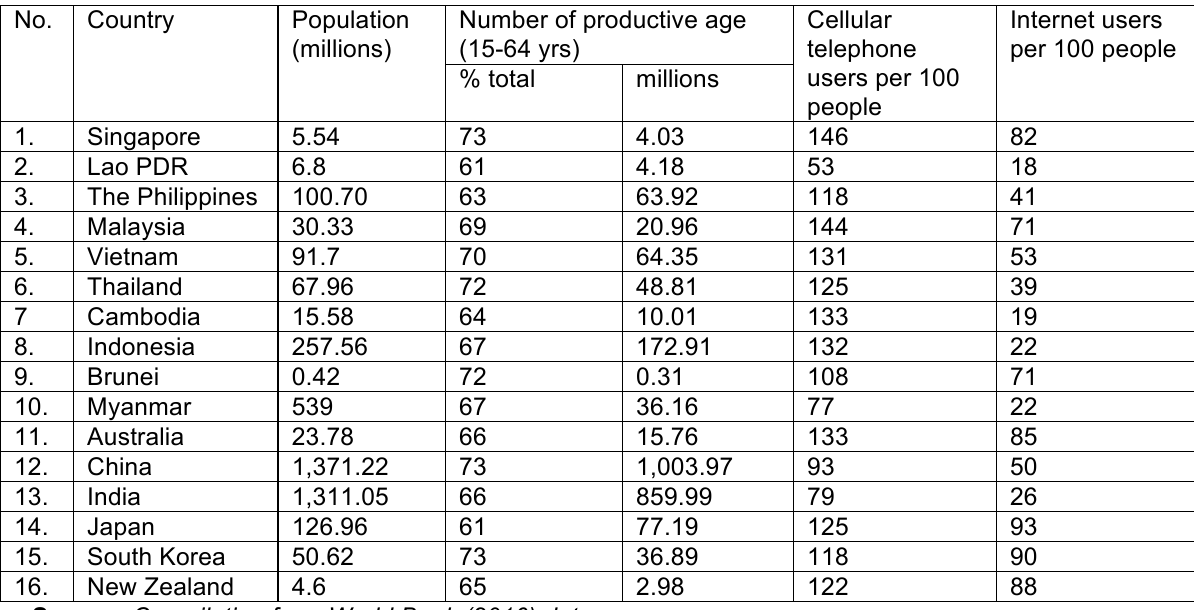
Table 3: Population, productive age, cellular telephone users, and internet users in the ASEAN